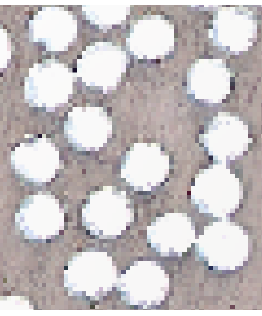
Figure 15. Micrograph section used for validation and sensitivity